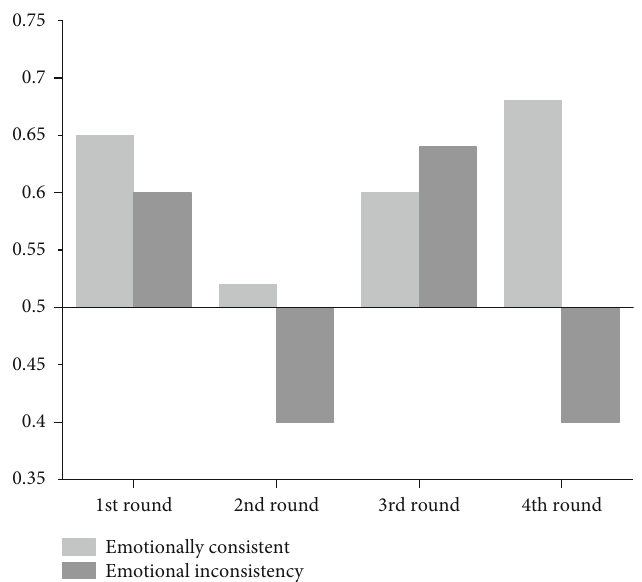
Figure 3: Average correct rates of the experimental and control groups in di ff erent